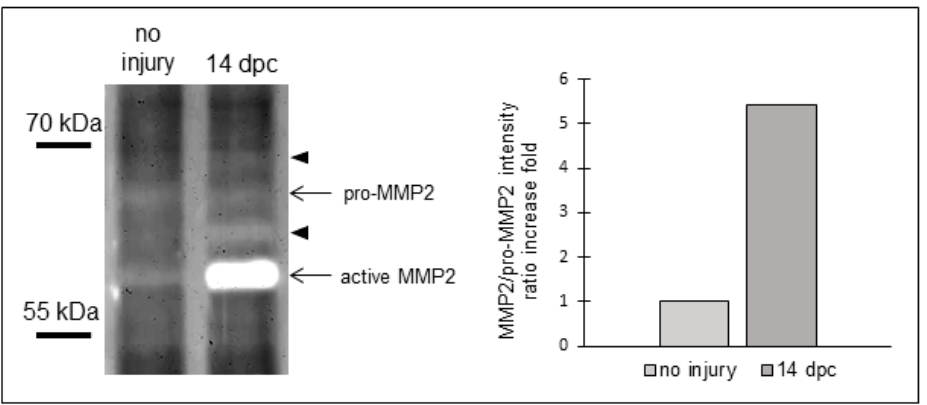
Figure 3. MMP2 activity increases in zebrafish ventricles after cryoinjury. Gelatin zymography in uninjured and 14 dpc hearts (eight ventricles per condition). Left panel: Zymogram showing gelatinolytic bands for pro and active MMP2 and additional gelatinolytic bands for undetermined MMPs (arrowheads). Right panel: MMP2/pro-MMP2 intensity ratio.